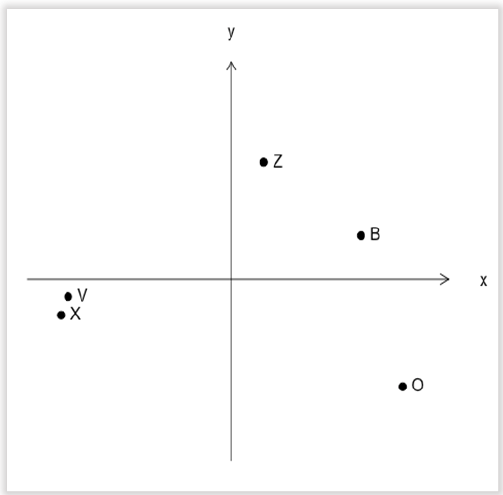
the dissimilarity matrix (see Table 2) calculated from the combined data of the four mares. (Figure